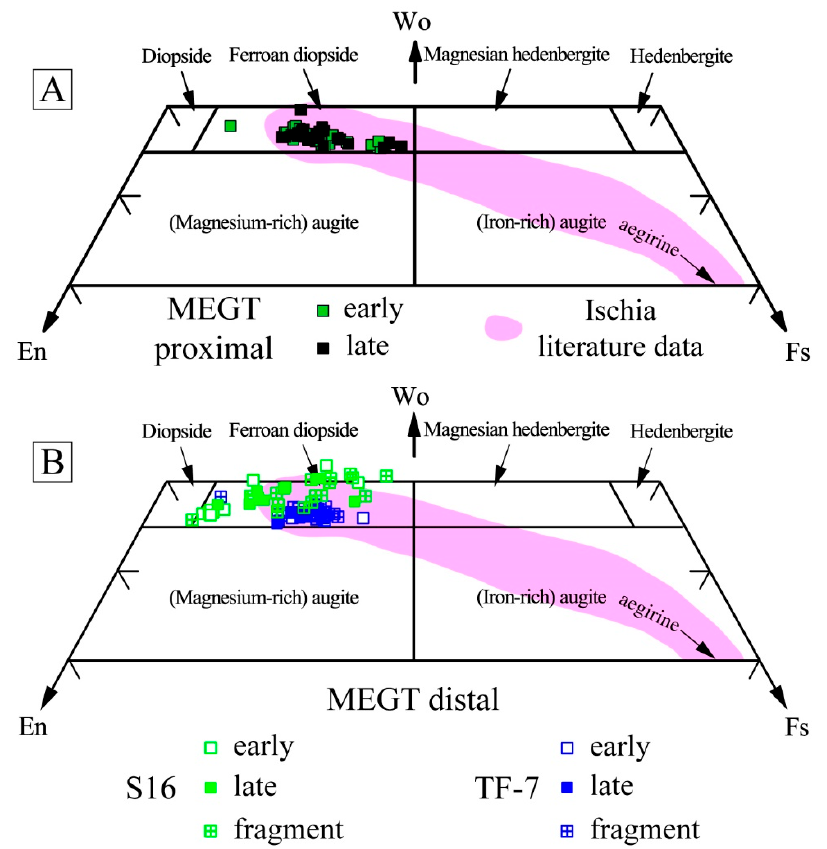
Figure 4. Pyroxene quadrilateral classification diagram Di-Hd-En-Fs [51]. ( A ) clinopyroxene crystals analysed in the selected MEGT volcanic rocks. The pink field has been drawn using mineral chemistry data on Ischia trachytes and phonolites from the literature [14,19,41,43]. ( B ) clinopyroxene crystals and fragments separated from samples S16 [7,8] and TF-7 [2]. See Discussion for details. Early = phenocryst core; late = phenocryst rim, microphenocrysts and microlites; fragment = broken crystal for which it is not possible to ascertain the original shape.